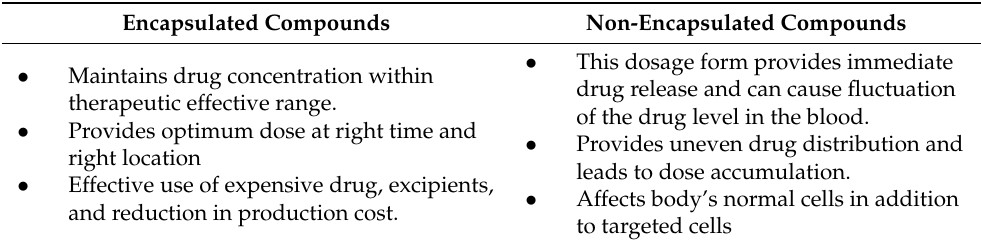
Table 2. Comparison between encapsulated and non-encapsulated compounds. Encapsulated Compounds Non-Encapsulated